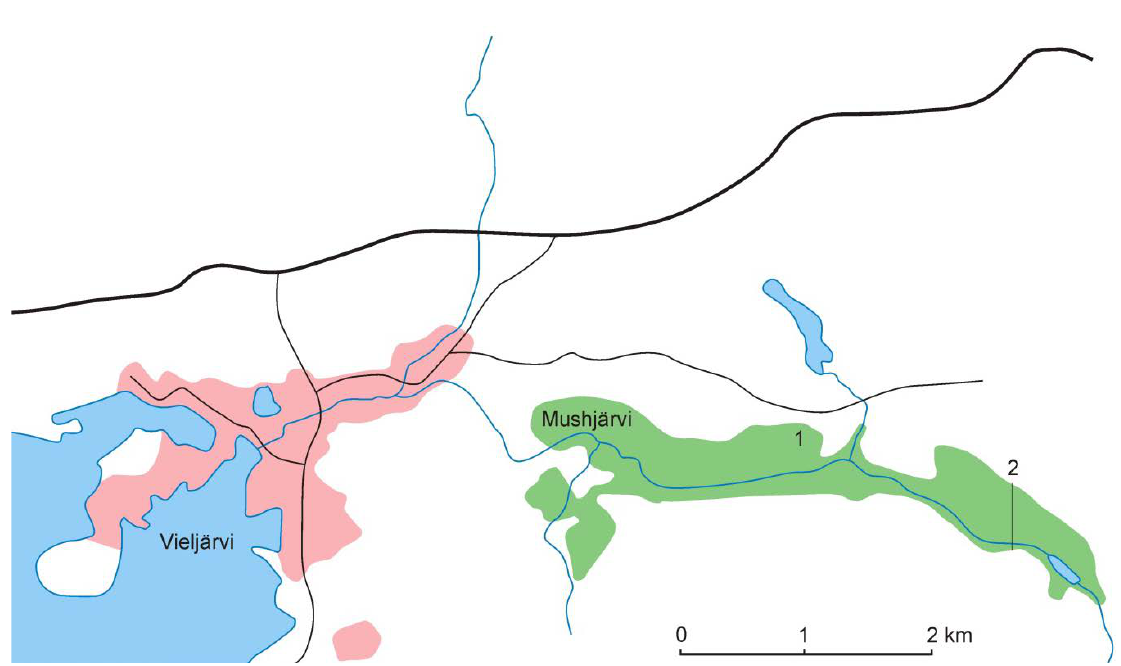
Figure 2. The rich fen (green) east of Vieljärvi village (red). 1: the studied area east of Lake Mushjärvi; 2: the profile studied by Fagerström & Luther